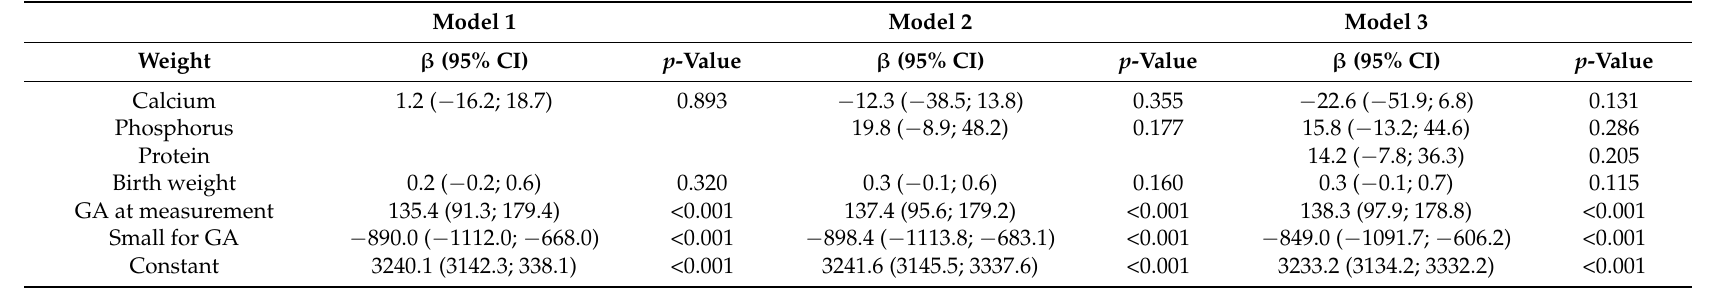
Table 6. Associations between nutritional intake and outcomes at term corrected